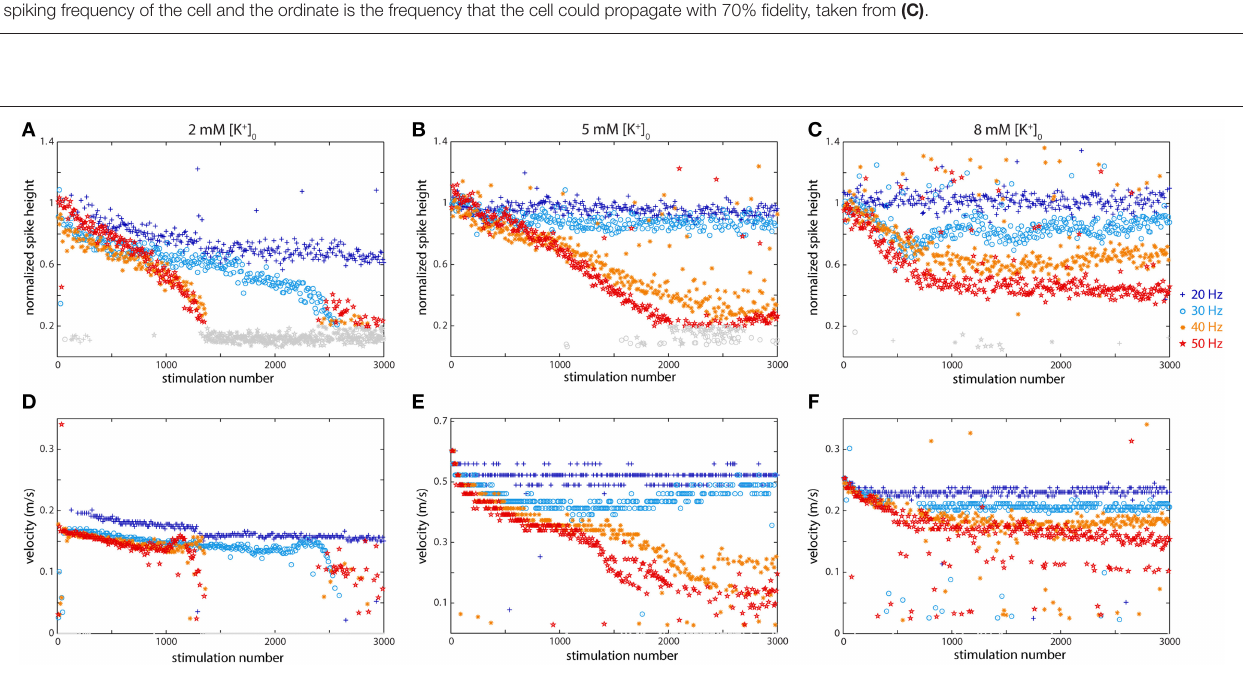
FIGURE 5 | Potassium concentration affects axonal propagation at higher frequencies including both the spike height (A–C) and the propagation velocity (D–F). (A,D) Low K + concentration 2mM) caused much more dramatic effects and propagation failures than regular conditions. (B,E) Regular (5mM) K + concentration in the medium. (C,F) High K + concentration (8mM) also altered axonal behavior, but not as dramatically. Propagation velocity was affected by K + concentration: both higher and lower [K + ] slowed propagation.